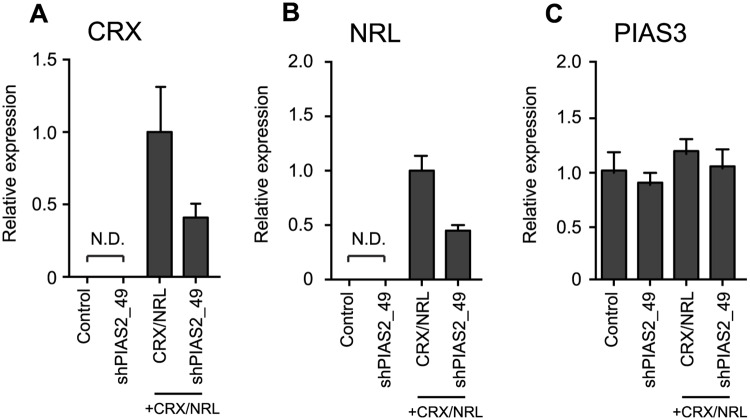
Relative mRNA expression level of Rhodopsin regulating factors in HEK293 cells.HEK293 cells were transfected with rho-Gluc reporter in combination with shPIAS2, CRX, and NRL expression vectors. Relative mRNA expression level of CRX (A), NRL (B), and PIAS3 (C) quantified by qPCR at 2 days after the transfection. N.D. represents no data. Error bars are shown as SE.